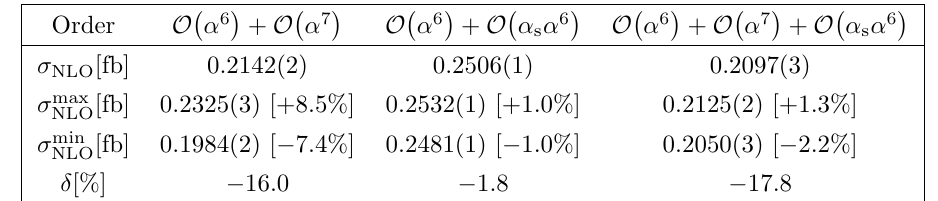
]. O ( (cid:11) 6 ) 1 to the LO LO (cid:0)